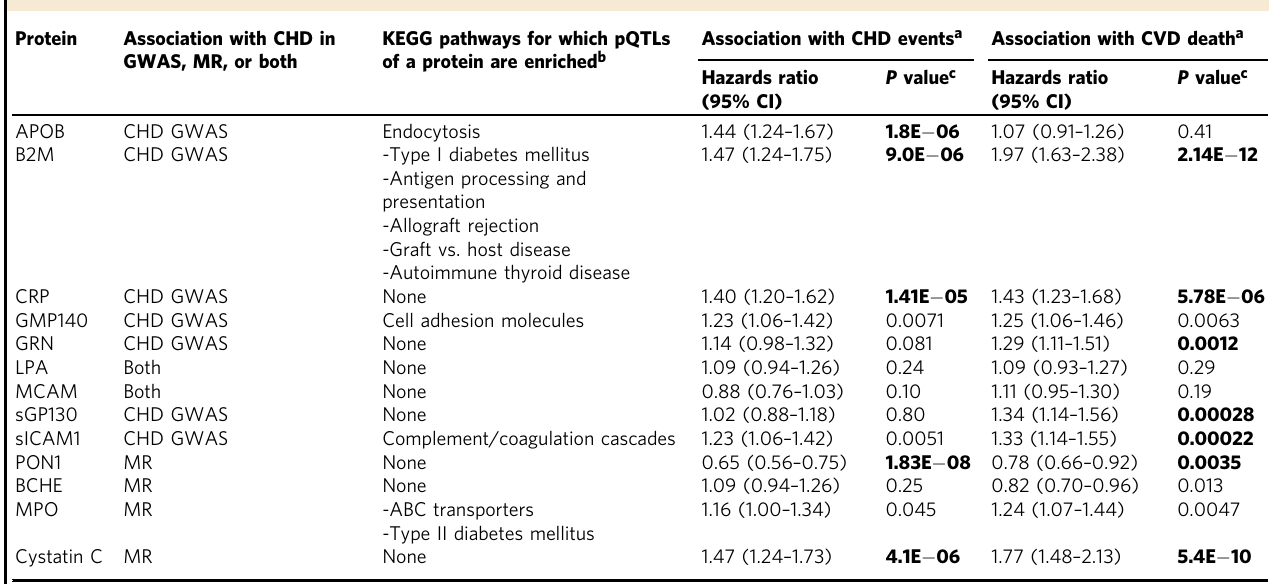
Table 2 Protein associations with coronary heart disease events and cardiovascular disease death in Framingham Heart Study participants with long-term